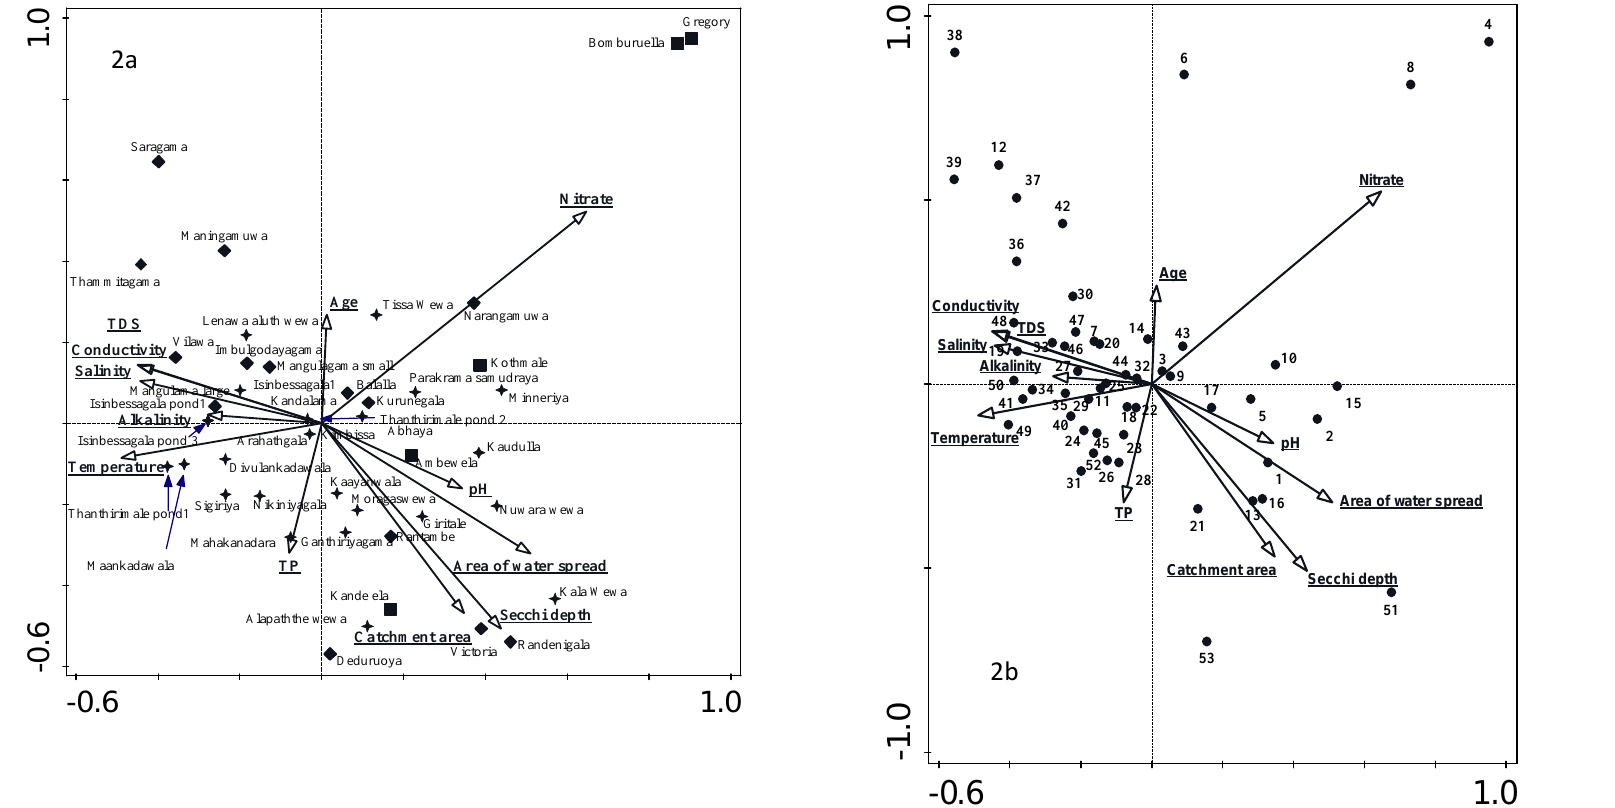
Figure 2: Canonical Correspondence Analysis (CCA) of sites (2a) and species (2b) with environmental variables. Solid arrows represent forward selected environmental variables and dashed arrows represent environmental variables that were plotted passively in the ordination. (TDS = Total Dissolved Solids) (1. Aulacoseira granulate , 2. Microcystis aeriugenosa , 3. Coelastrum sp., 4. Fragillaria crotonensis , 5. Fragillaria species 1, 6. Scenedesmus abundance , 7. Scenedesmus quadricauda , 8. Nostoc